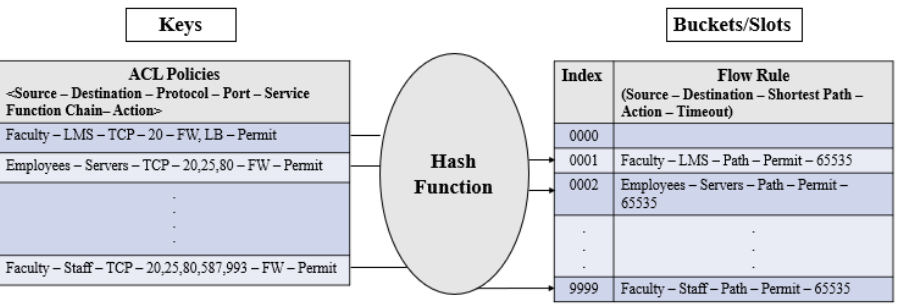
Figure 3. Flow Rule